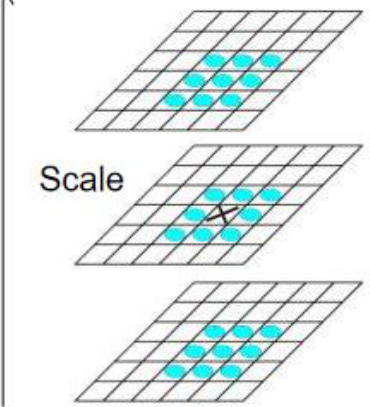
Figure 1. Spatial extremum